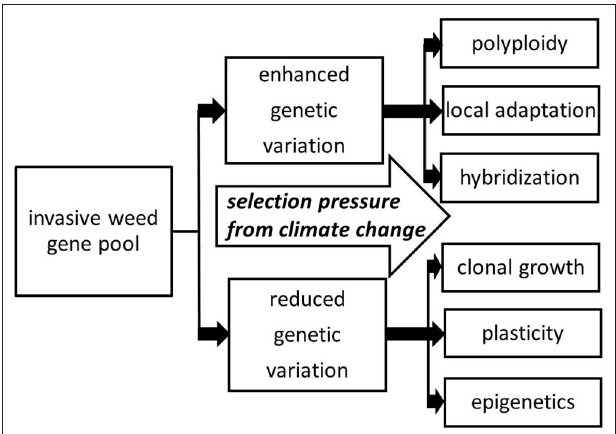
FIGURE 1 | Various directions that selection pressure from climate change can act to build on the invasive weed gene pool, including evolutionary mechanisms involving both increased and decreased genetic variation. By and large, these mechanisms are already operating for a given species prior to encountering climate change stressors, with these mechanisms providing channels for further